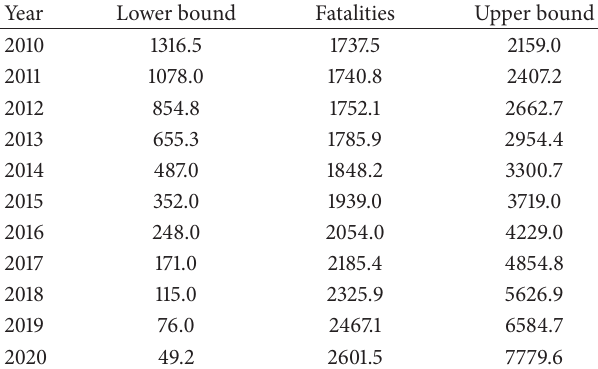
Figure 2: Modelled (1995–2009) and forecasted (2010–2020) abso- lute numbers of Cambodian fatalities, including their 68% confi- dence limits, according to the low vehicle growth scenario.